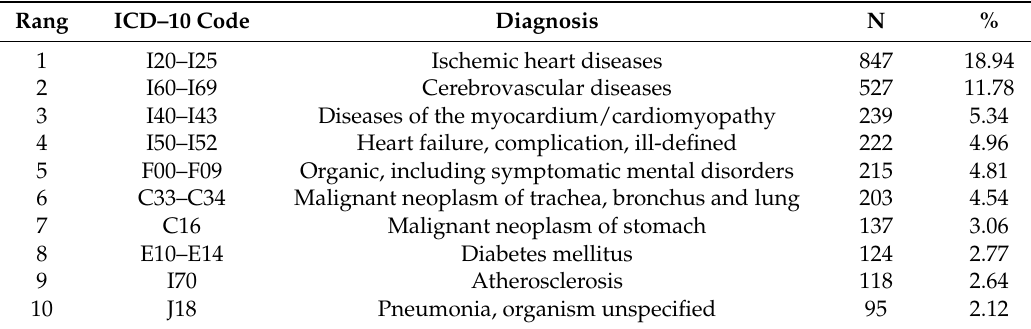
Table 4. Ranking and share of 10 leading causes of death in the town of Bakar 1960–2012.